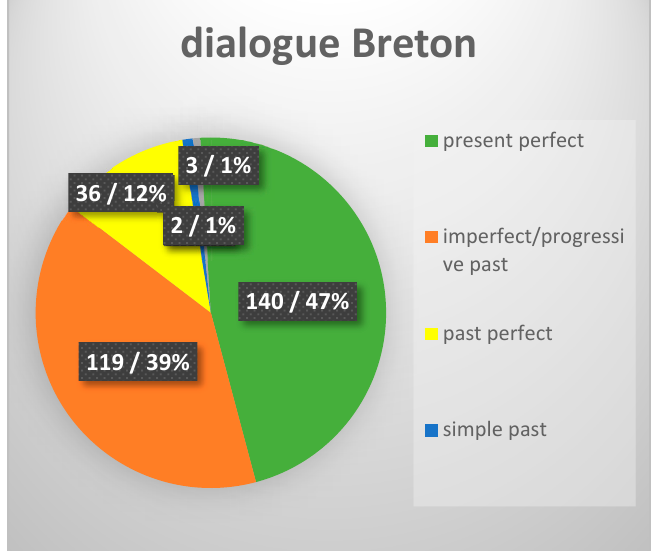
Figure 4. Distribution of Breton past forms in corpus B (dialogue with weak narration).